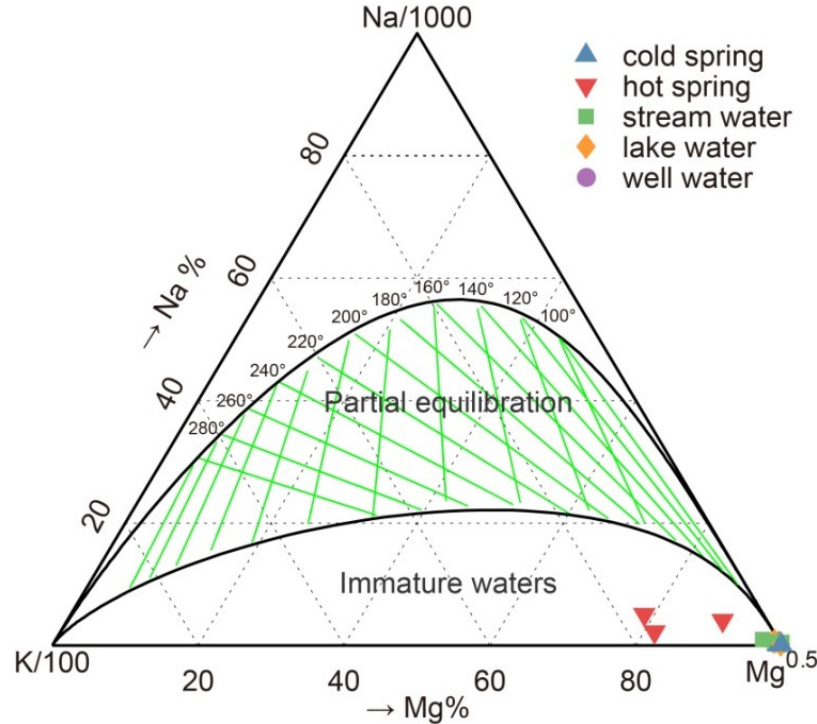
Gibbs diagrams were constructed by the equivalence ratios of Na + /(Na + + Ca 2+ ) and Cl − /(Cl − + HCO 3 − ) versus TDS. This method has been widely used to identify hydrogeo- chemical evolution processes, which involve precipitation, rock weathering, and evapo- ration–crystallization [34]. As shown in Figure 5, except for three hot springs, all other water samples collected in this study lie in the rock-weathering dominance area, indicat- ing that the main hydrochemical process of the local water is water–rock interaction. How- ever, three samples collected from the hot springs fell within the transition region between evaporation and rock-weathering, suggesting that the water in the hot springs was influ- enced by both evaporation and water–rock interactions, possibly due to the high temper- Figure 4. Na-K-Mg ternary diagram for all water samples. Figure 4. Na-K-Mg ternary diagram for all water samples. ature.